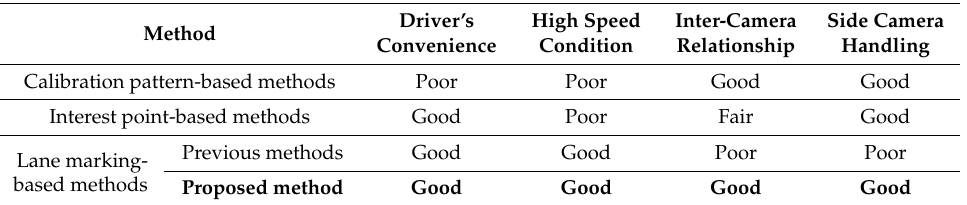
Table 6. Comparison of the previous and proposed